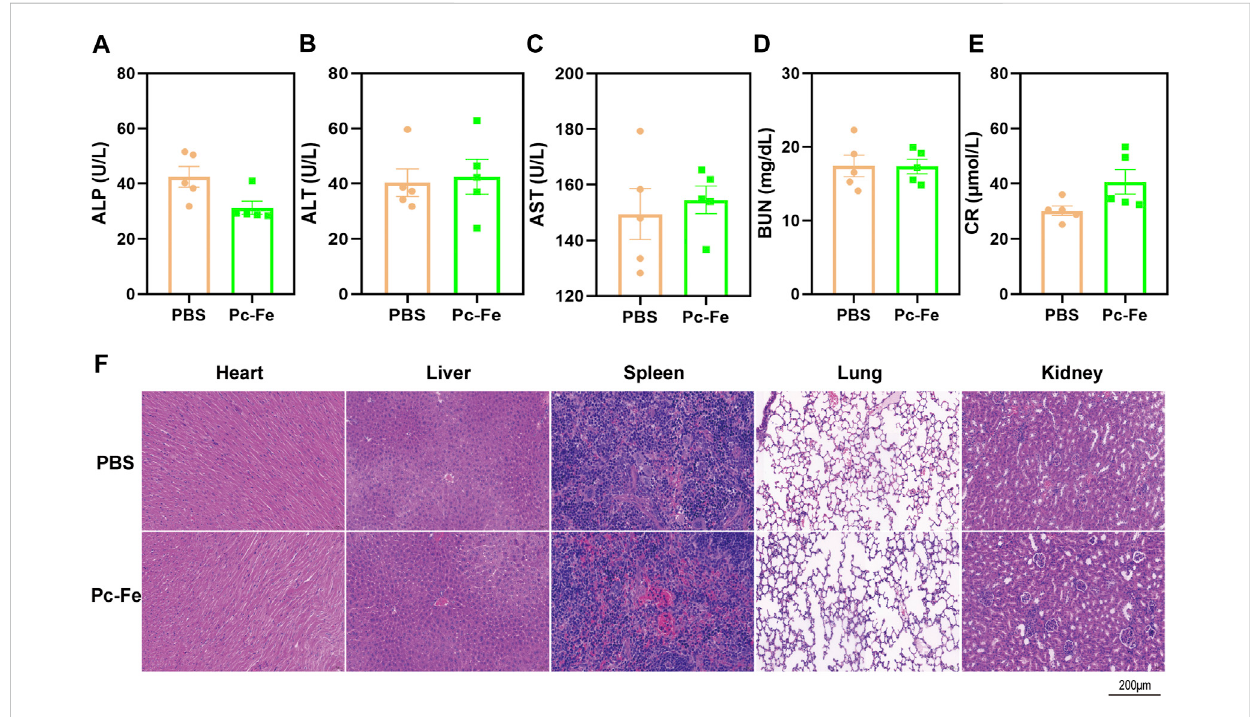
FIGURE 7 Invivo toxicityassessmentofPc-Fe. (A – E) BloodhematologicalanalysisofmiceafteroraladministrationwithPc-Fe.(Dataisshownasmean±SEM). (F) H&E staining of the sections of major organs including heart, liver, spleen, lung and kidney harvested from the mice in the PBS group and the Pc-Fe